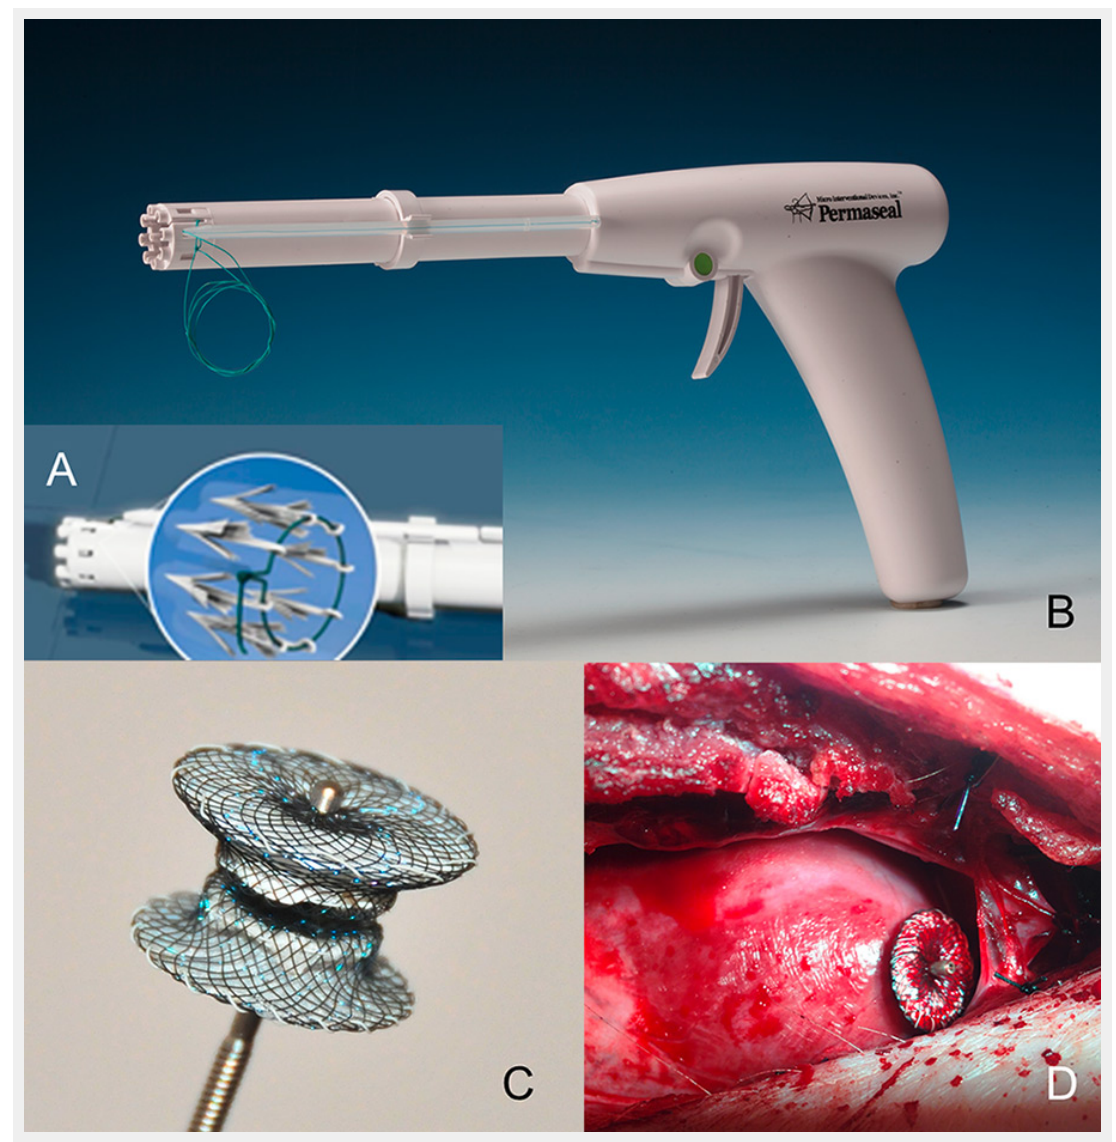
Figure 2 (A) The Permaseal TM device is made of eight polypropylene V-stays inserted in the left ventricular apex. (B) The gun-shaped Permaseal TM delivery system (Source: courtesy of Micro Interventional Devices). (C) The Safex TM is a self-expandable, self-anchoring and self-sealing flexible device. (D) Surgical view of the Safex TM